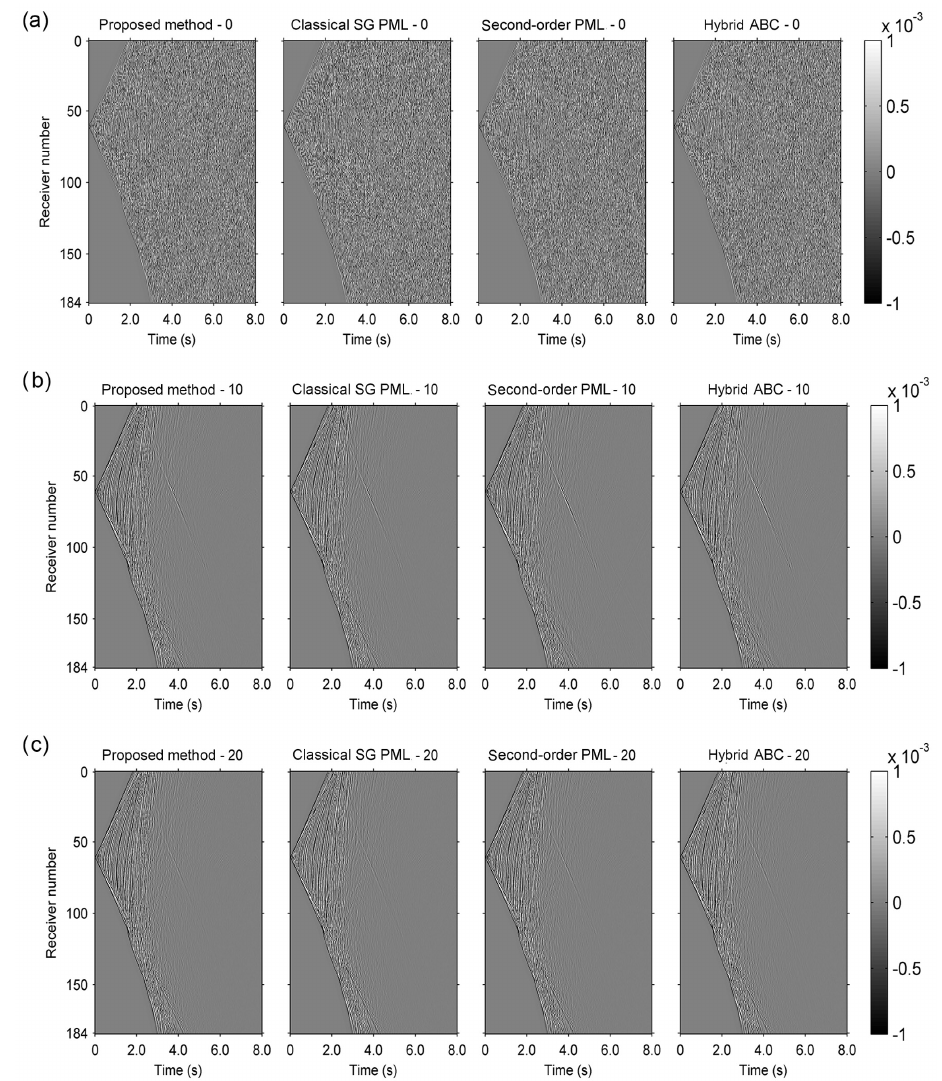
Figure 18. Receiver records for the four methods for a different number of absorbing layers: (a) 0 absorbing layers, (b) 10 absorbing layers, and (c) 20 absorbing